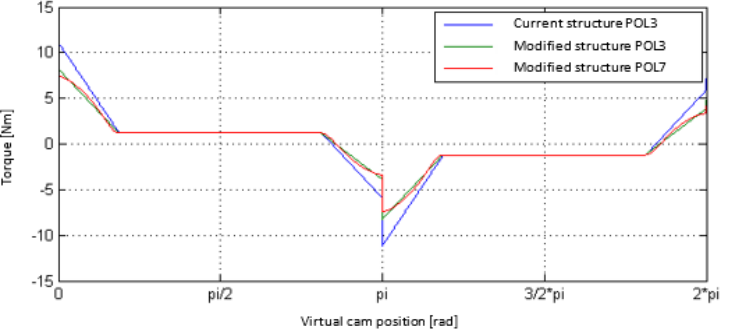
Figure 13. Course of torques during one period of reverse motion of the P1 drive of the investigated systems, application of polynomials of the 3rd and 7th degree in the lift dependences describing the position of the cylinder.